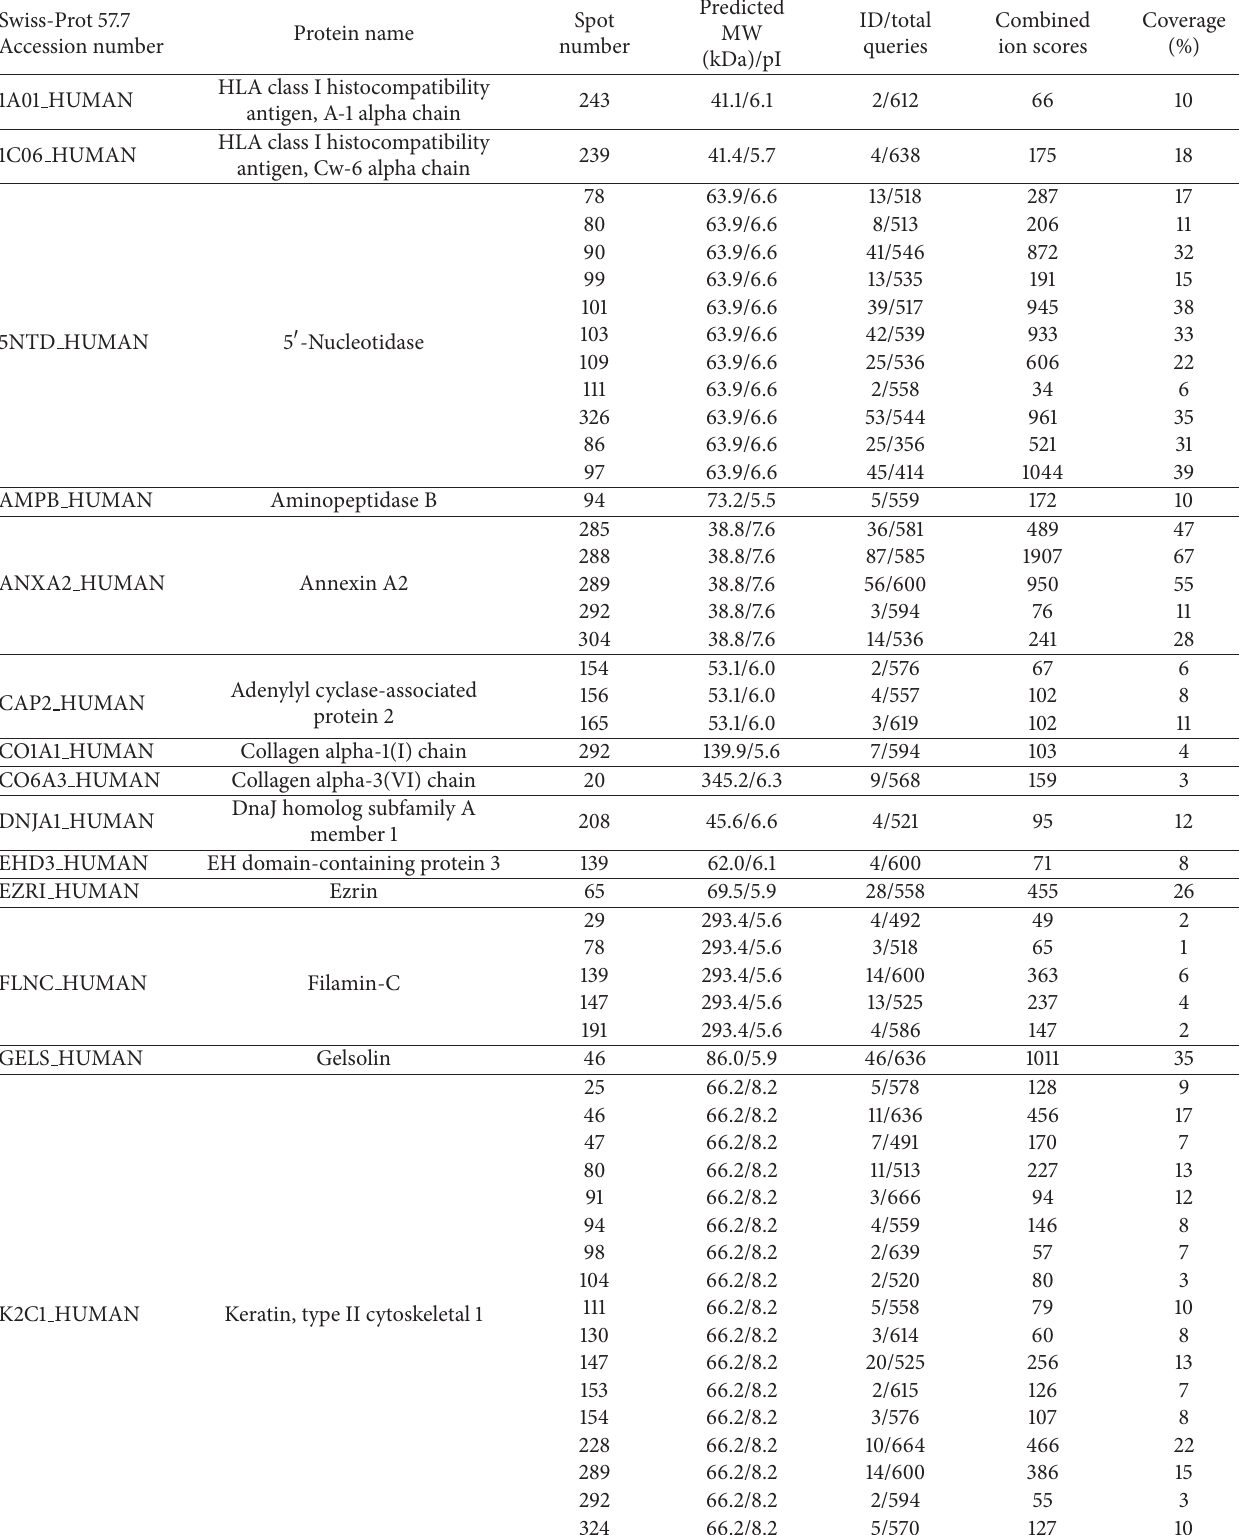
Table 2: Membrane-associated proteins on human